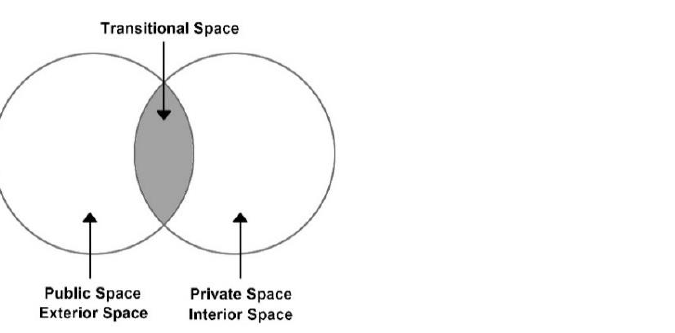
Figure 2. Some spaces that have been defined as transitional spaces in previous research. 2. Methods 2.1. Research Process This study focuses on the effects of curved and linear environments on the stress recovery of humans in transitional spaces. Firstly, it is assumed that curved and linear spaces have different stress recovery effects for humans in the transitional space. The Trier Social Stress Test (TSST) has been proven to induce moderate psychological stress in which participants must present a speech (5 min) and perform mental arithmetic (5 min) in front of an audience [47]. Thus, a 10 min TSST experiment was conducted with the participants to increase the participants’ stress level. Then, participants were randomly entered into the VR scenario separately to test the effect of linear and curved environments in the transitional space on human stress recovery. During this process physiological, data are collected, including heart rate (HR) and blood pressure (BP). The blood pressure in- cludes the systolic blood pressure (SBP) and the diastolic blood pressure (DBP). Psycho- logical data are collected through the State-Trait Anxiety Inventory (STAI). Finally, data analysis is conducted by statistical product and service solutions (SPSS). 2.2. Research Tools This research uses a combination of virtual reality (VR), heart rate (HR), blood pres- sure (BP), and State-Trait Anxiety Inventory (STAI) to establish a systematic process to assess human emotions and to contribute to the harmonious development of humans and their environments. Virtual reality (VR) technology, with its immersive displays, allows for the rapid con- struction of a model and simulation of multiple spatial and environmental scenarios. VR is also often used as an experimental tool in the research of human emotions. Annerstedt et al. researched the effect of natural sounds on stress recovery, and the result showed that a VR scenario with natural sounds increased the stress recovery rate in humans [48]. By setting up different scenarios in VR and conducting experiments, Valtchanov identified a significant improvement in human stress in natural environments compared to urban and geometric environments [49]. Yin et al. recruited 28 participants to experience three ver- sions of a pro-biological design in an open and closed office space simulated in VR [50]. The results suggest that the pro-biological intervention can help reduce stress and increase